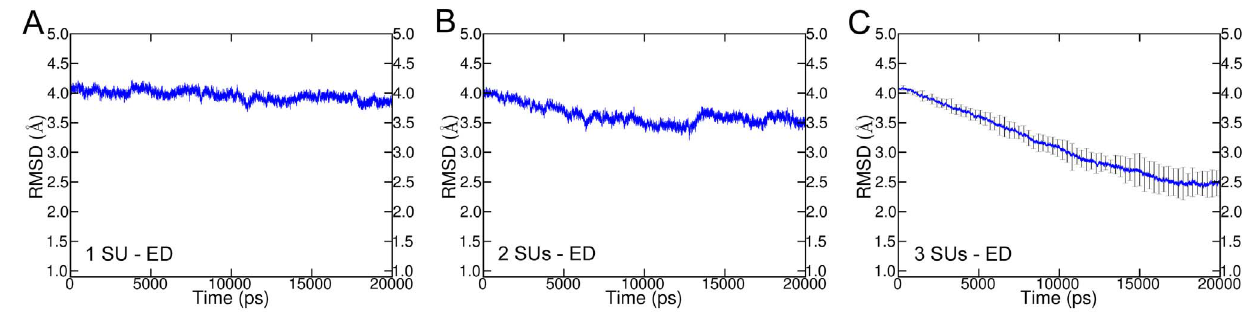
Figure 7. RMSD of cooperativity simulations. ED was applied on one (A), two (B), and three (C) SUs. The open structure was used as reference. For simulations with ED applied on one SU and two SUs, only one simulation each was performed. For ED simulations on three SUs, the average of the backbone RMSD without loops of ten simulations was measured. Standard deviation is indicated by the error bars.